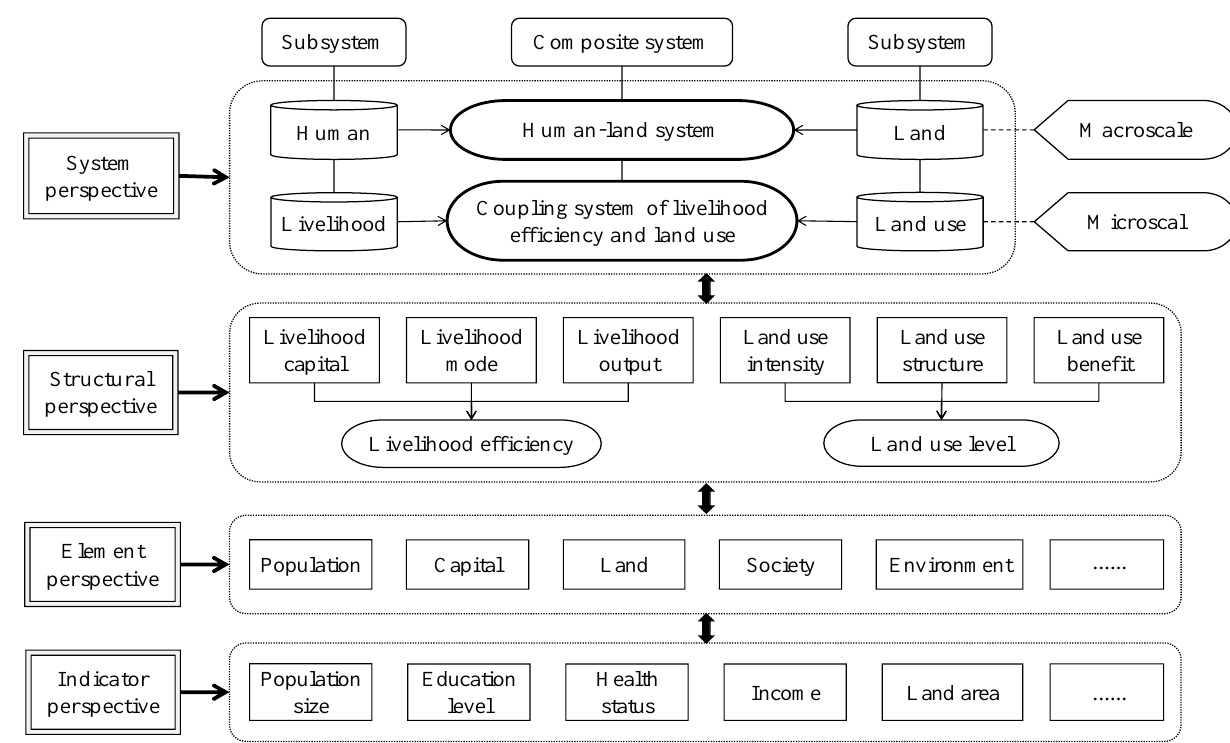
Figure 2. Hierarchical relationship of the human – land system.